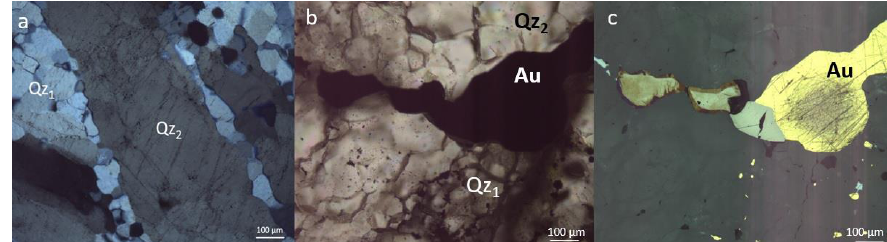
Figure 2. Different types of quartz from the Dobroe deposit: ( a ) granoblastic (Qz 1 ) and vein (Qz 2 ) quartz, ( b ) quartz with native gold in transmitted light, ( c ) quartz with native gold in reflected light. The ores contain calcite, siderite, and chlorite, as well as ore minerals which form nested dissemination and fissure segregations. The content of ore minerals does not exceed 5%, and the distribution of those in ores is extremely uneven. The early association of sulfides consists of pyrrhotite, arsenopyrite, and pyrite. Late association (chalcopyrite, galena, ulmanite, and Bi-Te minerals) in a subordinate amount forms microscopic segregations in quartz veins. Ore minerals are also found in the host schists as layered, disseminated aggregates, thin veinlets, and dispersed, fine, crystalline, granular dissemination. Microscopic (0.X – 0.00X mm) and larger (>1 mm) visible native gold form primarily in quartz veins as fractured, lamellar, and vein-like segregations (Figure 2b,c). Gold resulting from early association presents in the form of intergrowths with sulfides (pyrrhotite, arsenopyrite), as well as fracture segregations with subisometric inclusions in them (Figure 3a–c). Late gold has been found to be associated with galena and bismuth minerals (native bismuth and hedleyite) (Figure 3e,f). Regularly, late sulfides and gold form rims at the boundaries of pyrrhotite, arsenopyrite, and quartz. Similar intergrowths with early sulfides make up galena-bismuth-ulmanite aggregates which lack visible gold (Figure 3d).